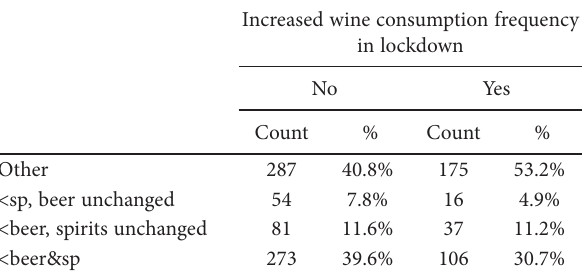
Table 6. Substitution effect in favor of wine and beer during the